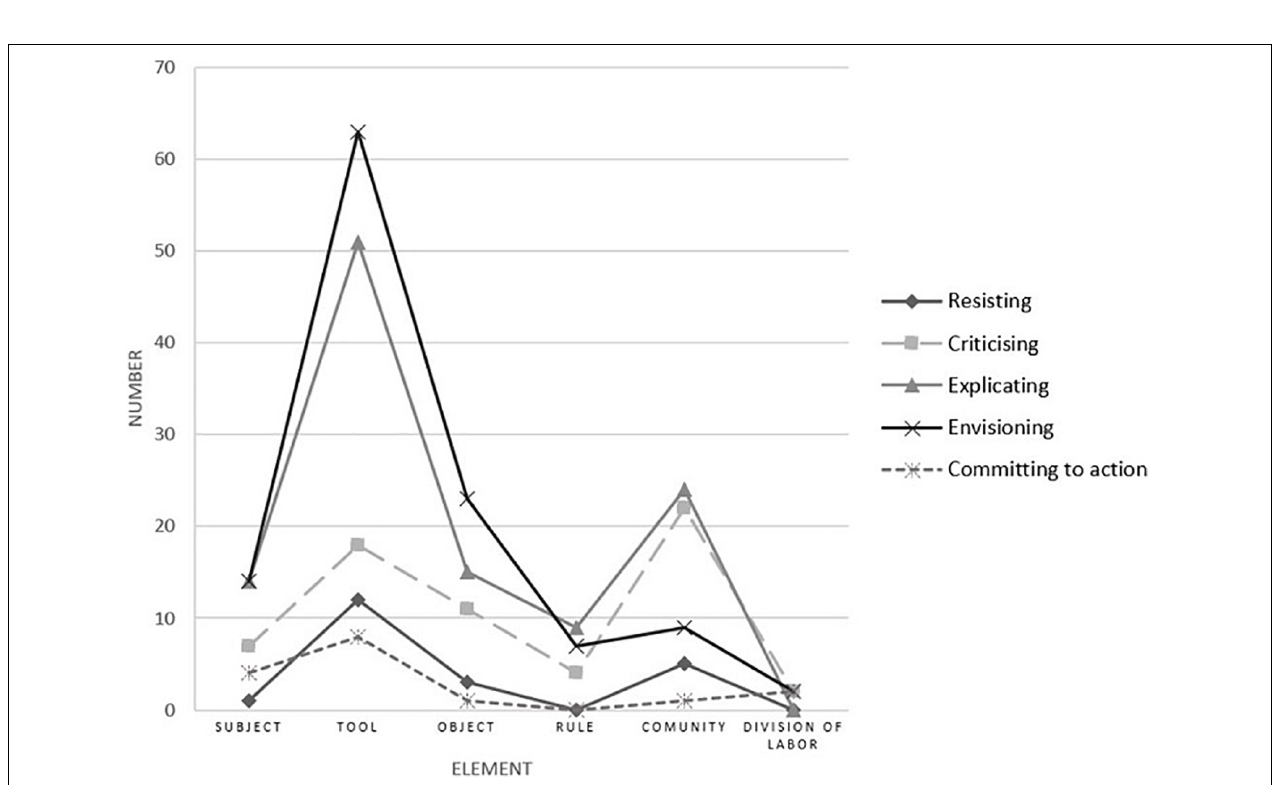
FIGURE 2 | The expression of transformative agency in the activity